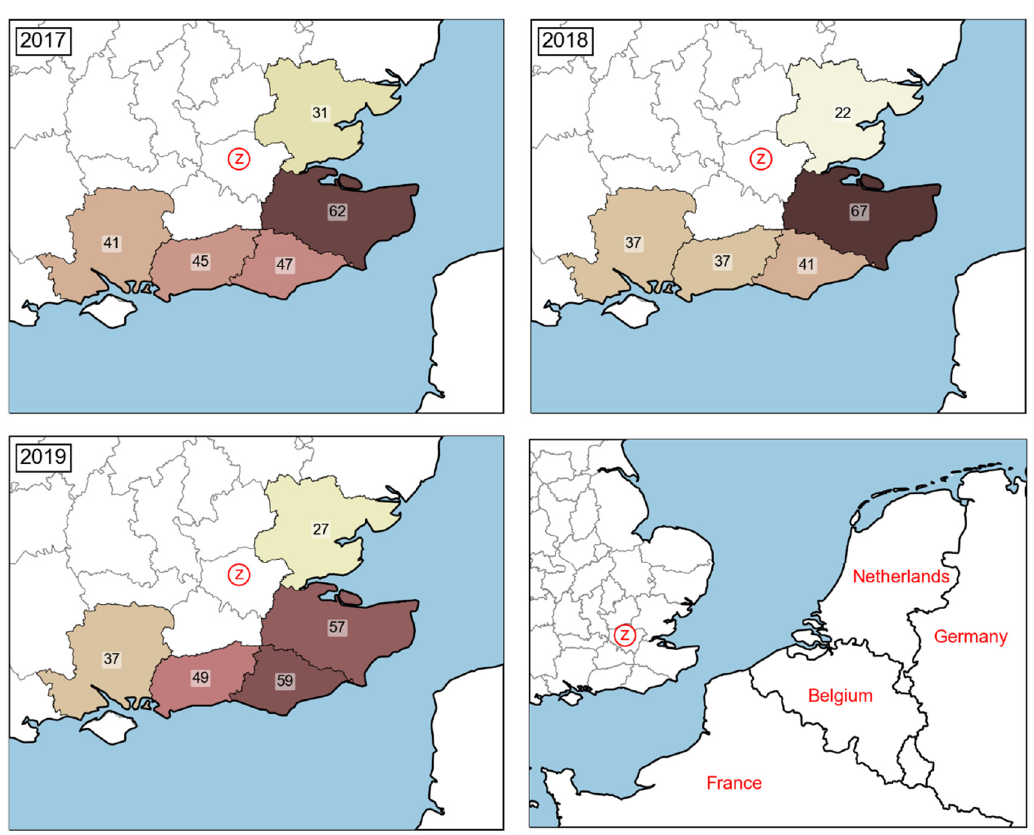
Figure 3. NAME-modelled Culicoides incursions from all European sources to the UK. Total number of potential incursions in 2017, 2018 and 2019 [114] . ZSL London Zoo is marked on the map in red.